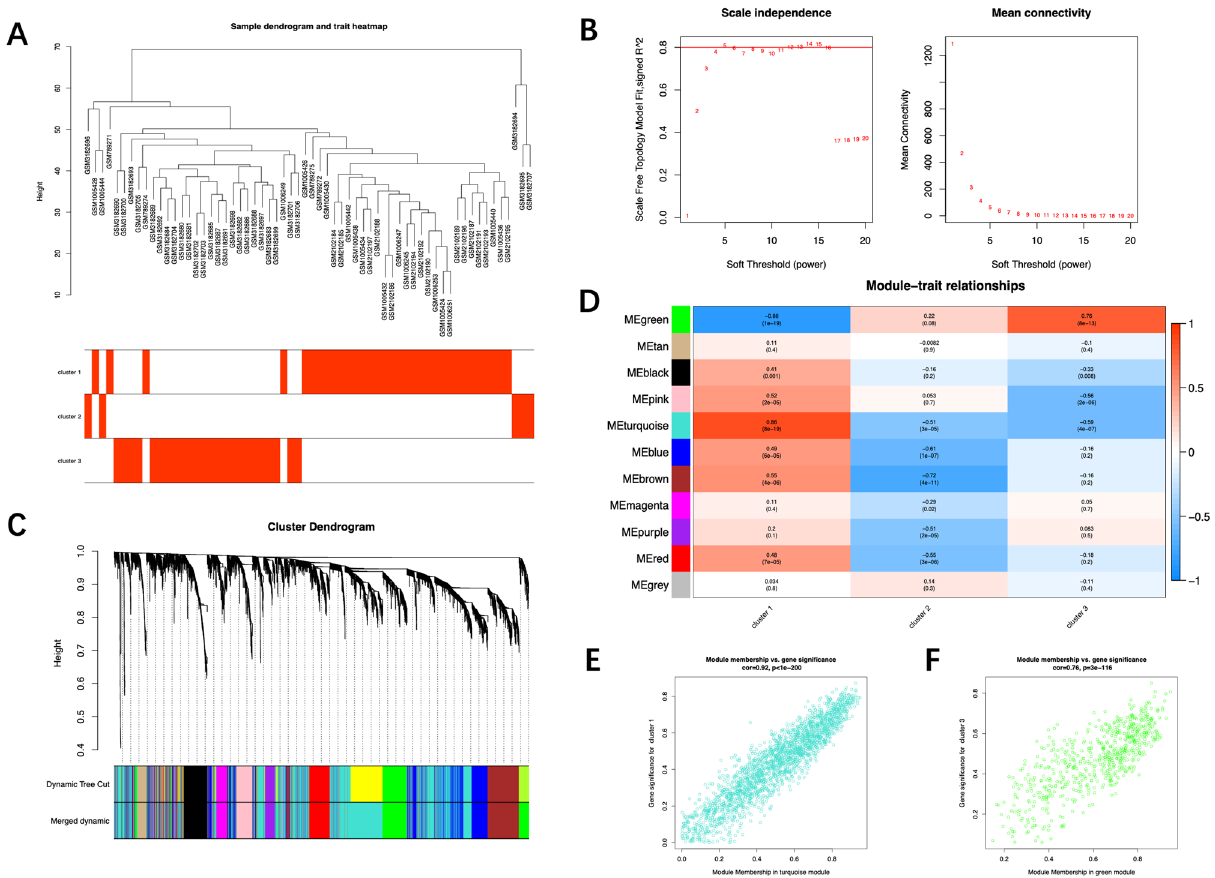
Figure 6. Construction of the weighted coexpression network and identification of key modules (‘WGCNA’ package). ( A ) Sample dendrogram and trait heatmap. The vast majority of samples were split into clusters 1 and 3. ( B ) The selection of the soft-thresholding power β. The red line was set at 0.80, and the soft-thresholding power β was 5. ( C ) Dendrogram of all the differentially expressed genes. ( D ) Module-trait relationships in the constructed network. The correlation in the green and turquoise modules was completely opposite between cluster 1 and cluster 3. ( E ) Scatter diagrams for module membership vs. gene significance of the disease state in the turquoise module. ( F ) Scatter diagrams for module membership vs. gene significance of the disease state in the green